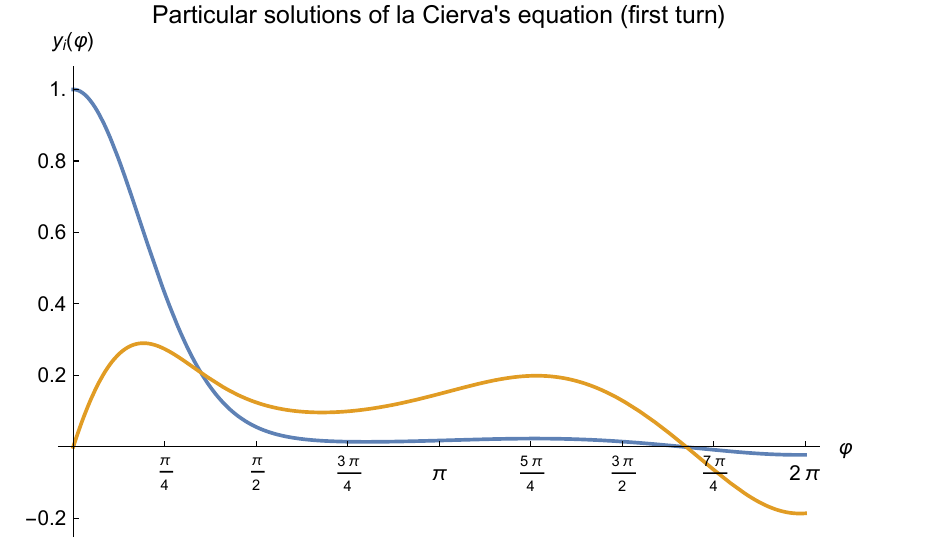
Figure 2. Second order Runge-Kutta approximations (obtained by the explicit midpoint method) to each particular solution of la Cierva’s equation according to the procedure described in Section 5, i.e., y 1 ( ϕ ) (blue line) and y 2 ( ϕ ) , where ϕ varies in the range [ 0,2 π ] , which means a turn of the blade of the autogiro, and the choice of parameters was as suggested by Mr. la Cierva, i.e., m = 0.5 and λ =